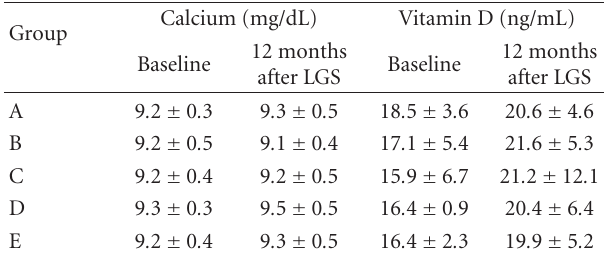
Table 5: Calcium and vitamin D before and after